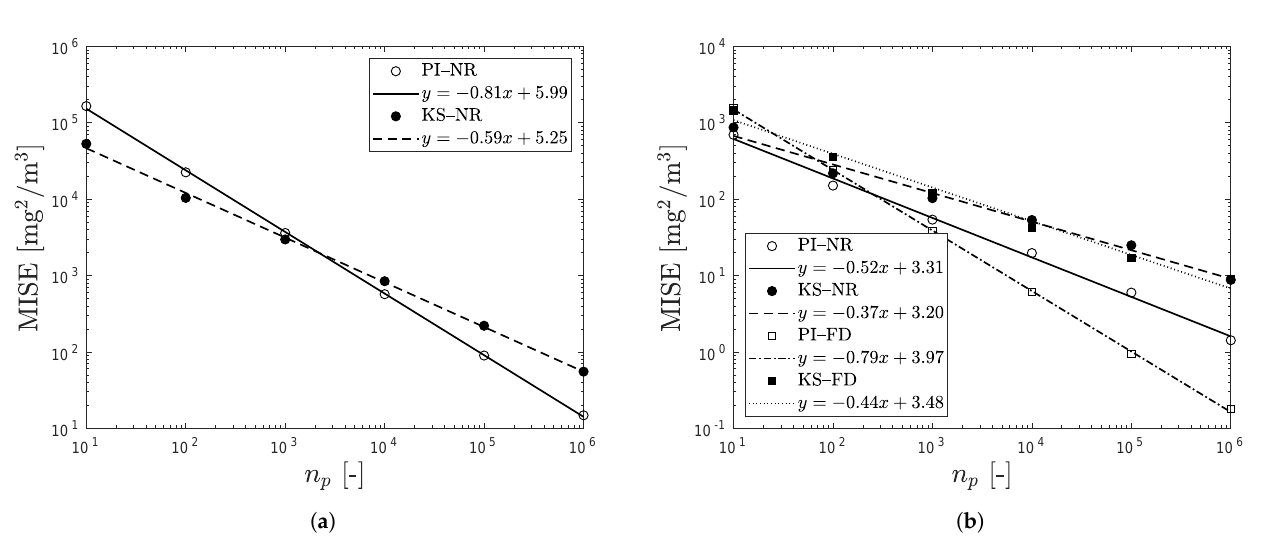
Figure 2. MISE against the released number of particles n p for the PI and KS estimator in an unstable atmosphere at ( a ) 24s and ( b ) 118s after release, NR refers to normal reference rule and FD to the finite difference (see text). The lines represent the least-squares estimate of the corresponding